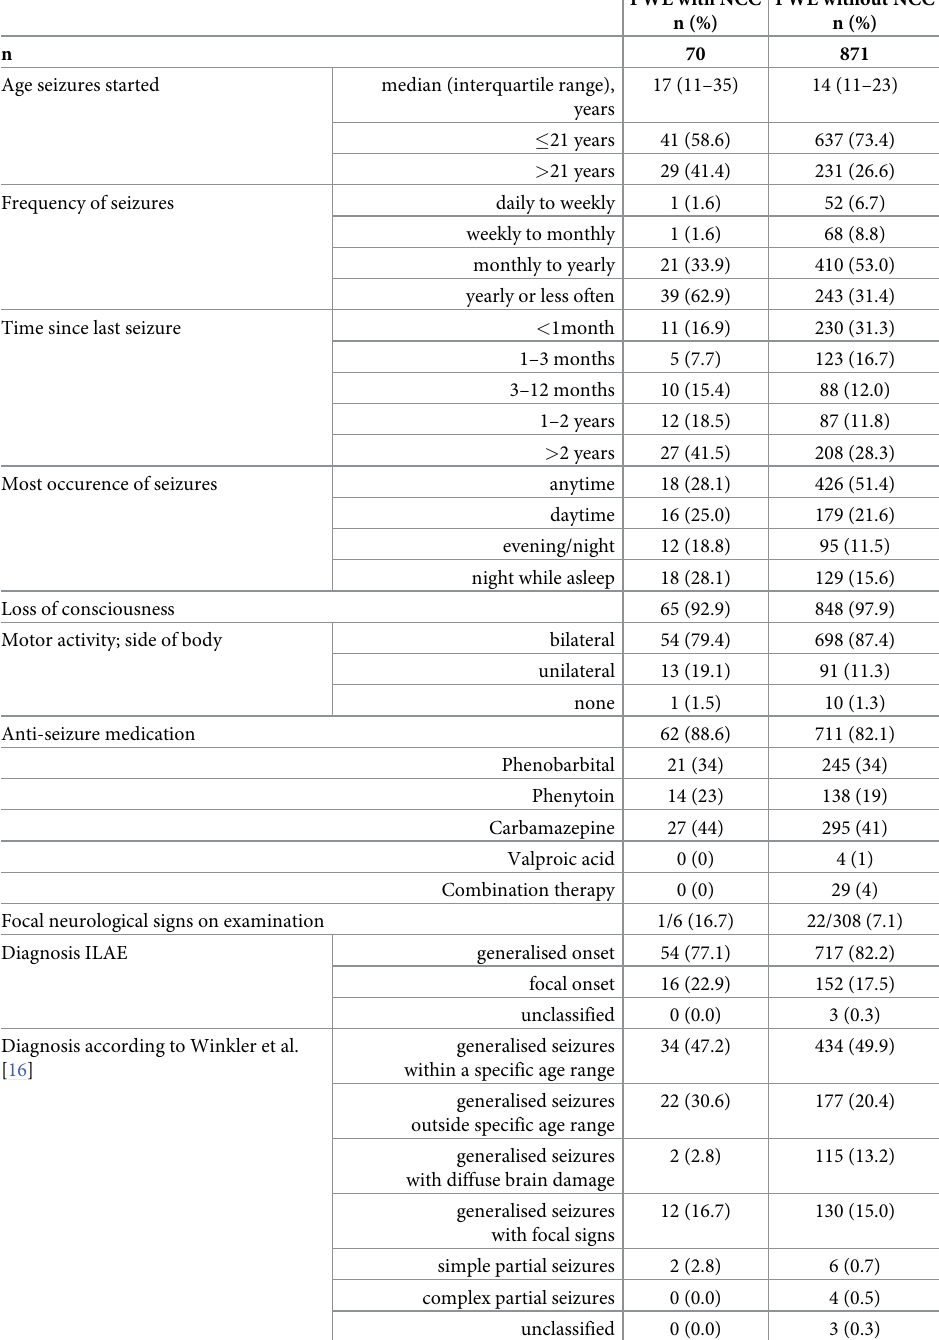
Table 3. Clinical characteristics of people with epilepsy with and without